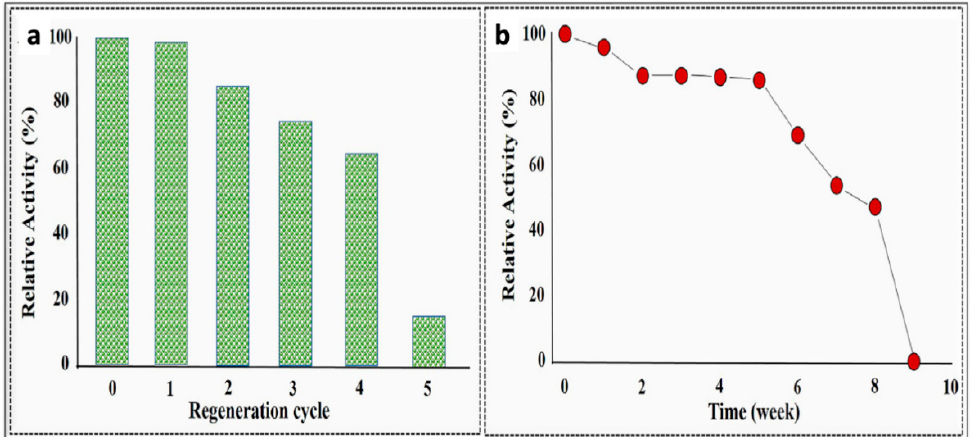
Figure 15. ( a ) The P3-TMA IL-1 β sensor could be regenerated with some loss in activity for up to five cycles. ( b ) When stored dry at 4 °C, the sensor retained over 80% of its activity after 5 weeks [78].